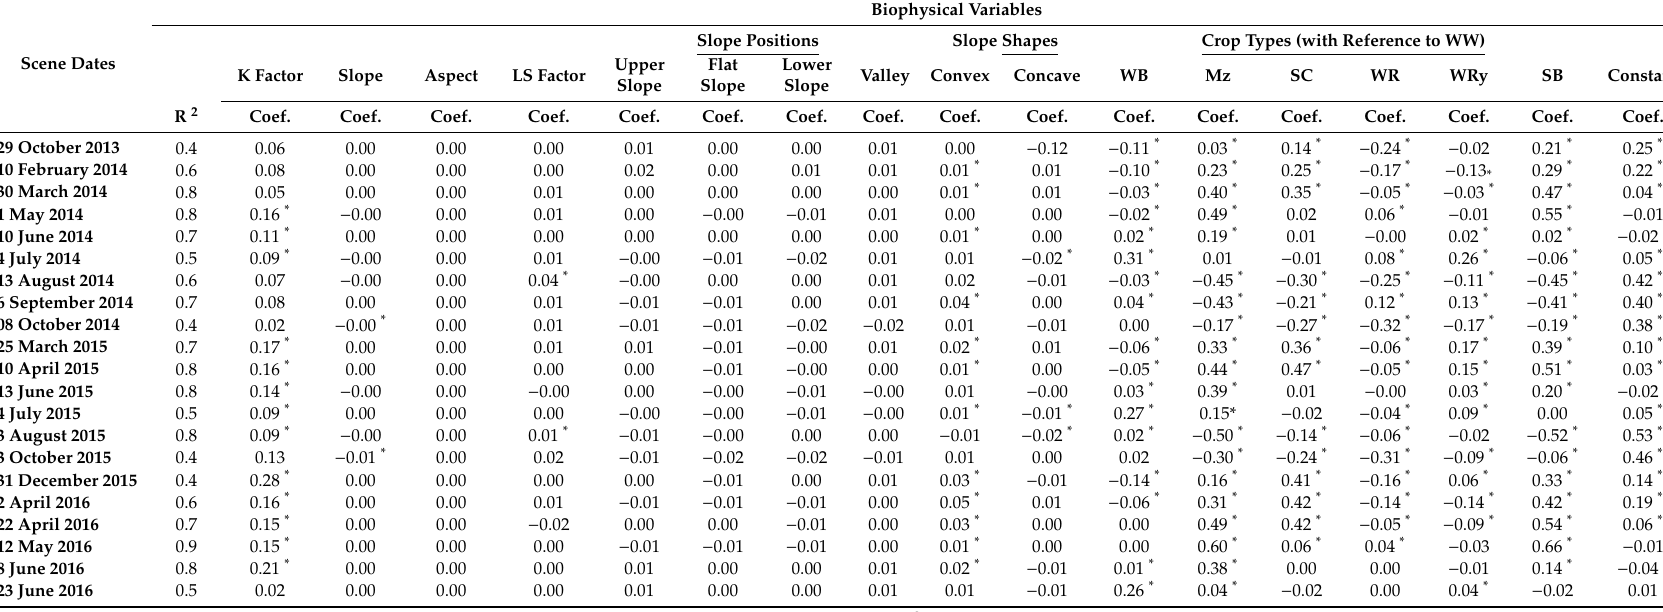
Table 5. Estimates of the multiple regression analysis of C ndvi values against biophysical variables across the multi temporal